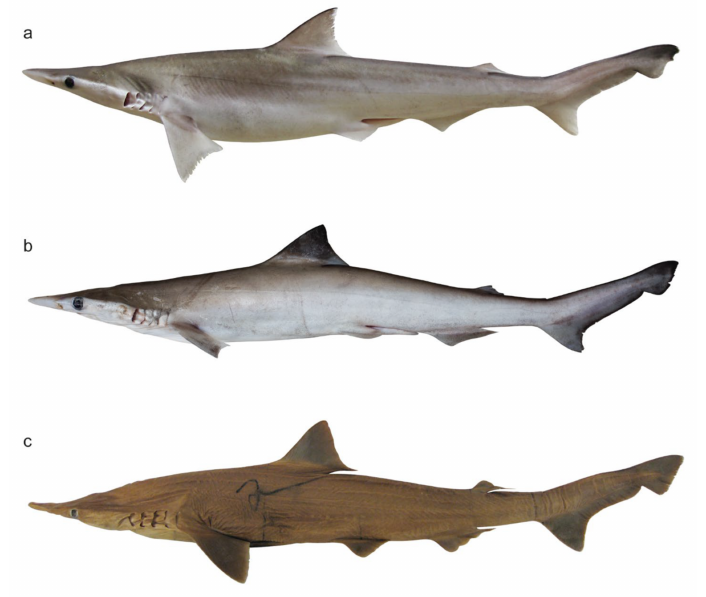
Figure 1. Lateral view of Scoliodon ‘species’. ( a ) S. macrorhynchos IPPS WWPLAL#1 (adult male 426 mm TL, fresh), ( b ) S. cf. laticaudus CSIRO H 8401-09 (adult male 394 mm TL), and ( c ) S. laticaudus MNHN 1123 (female 524 mm TL,